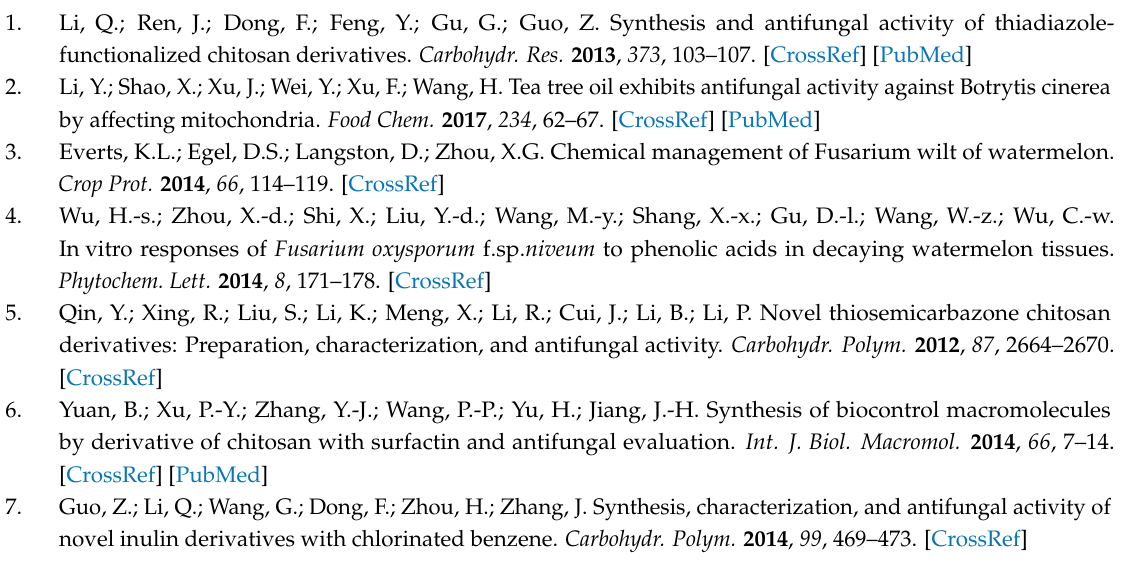
Figure 7. Antifungal activity of inulin and the inulin derivatives against F. oxysporum f.sp. niveum.